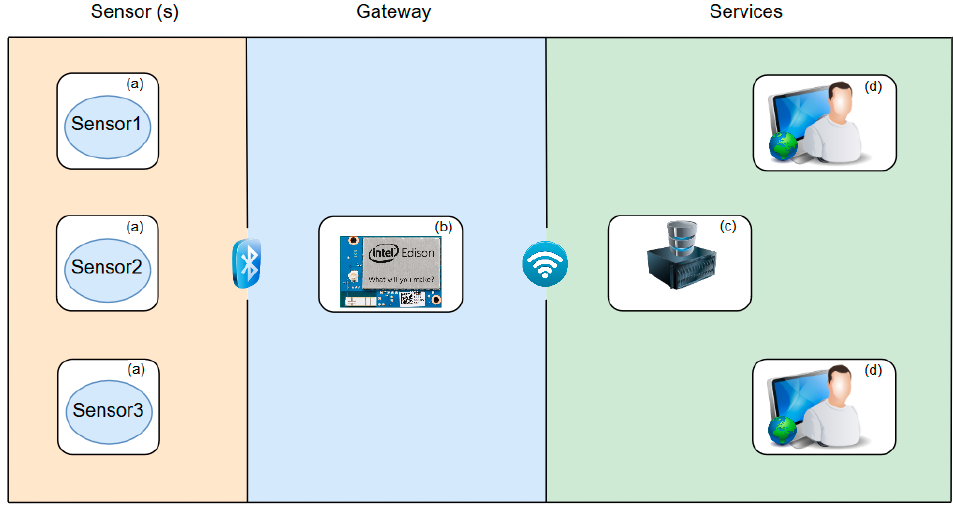
Figure 1. The system architecture. ( a ) represents the sensor devices; ( b ) is the external data